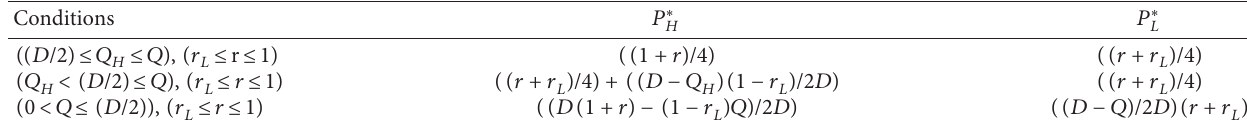
Table 3: The retailer’s optimal pricing decision.